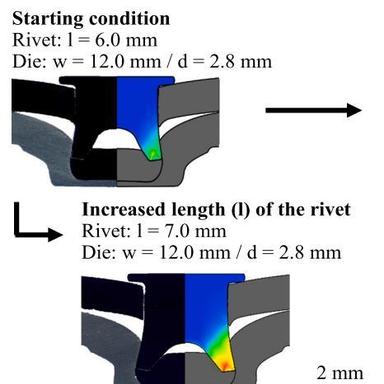
Change in joint and process characteristic in dependence on the die geometry and the rivet length.